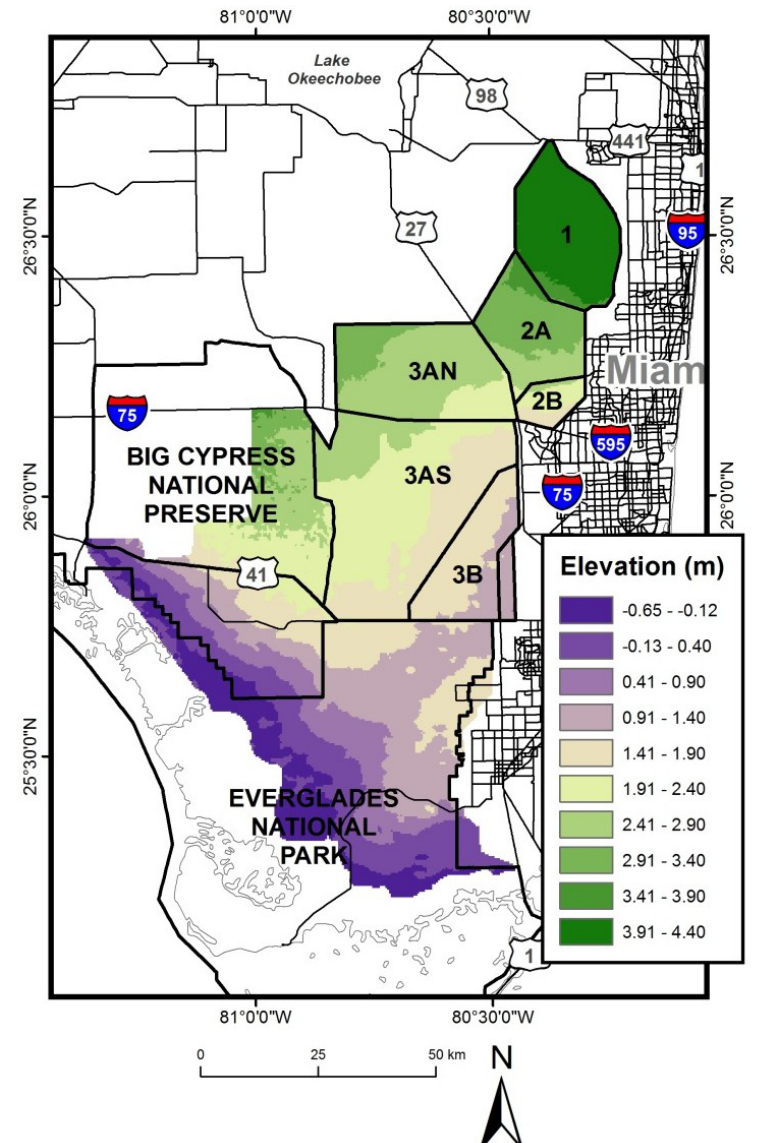
Figure 1. The Greater Everglades region of South Florida, USA. The digital elevation model covering the EDEN model domain, shows elevation in meters above sea level [8] and illustrates the extremely flat nature of the Everglades. Subtle differences in topography create variations in hydroperiod that dictate vegetation composition. Reliable information on inundation dynamics would be very beneficial to restoration science and resource management. Non-tidally influenced areas of Water Conservation Areas (WCA) 1–3 are labelled simply as 1, 2A, 2B, 3AN, 3AS, and